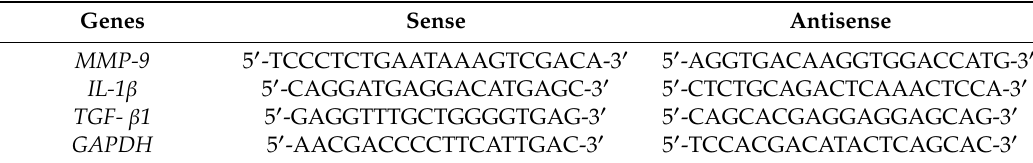
Table 2. Primers used in real-time PCR analysis in this